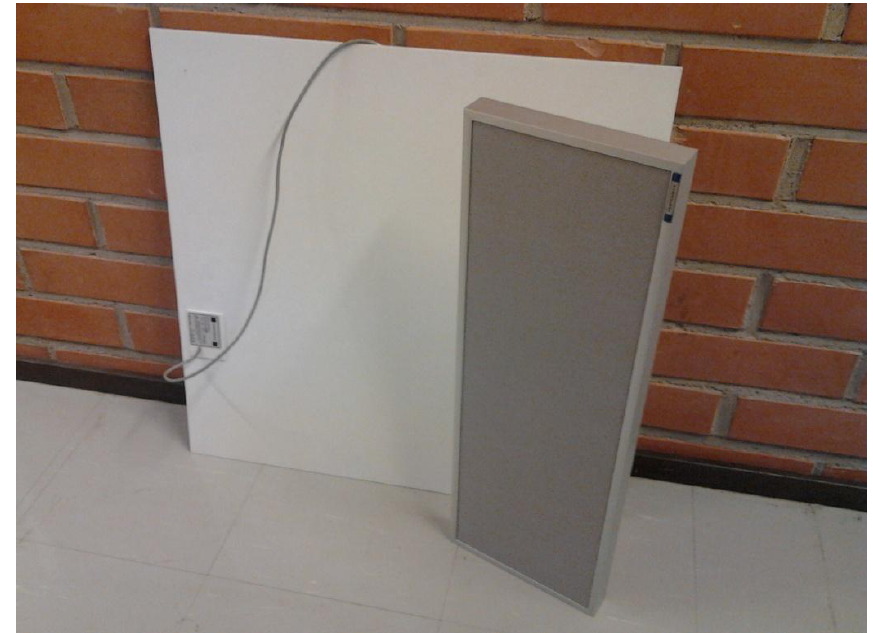
Figure 4. Examples of directional panel speakers (Panphonics Sound